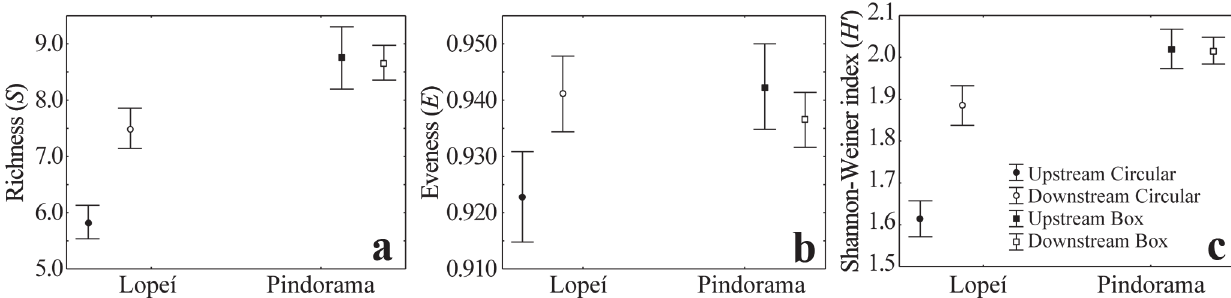
Fig. 8. Species richness ( S ) ( a ), evenness ( E ) ( b ), and species diversity (Shannon-Weiner Index - H’) ( c ) in the sampled stretches of the Lopeí stream - circular culvert and Pindorama stream - box culvert.